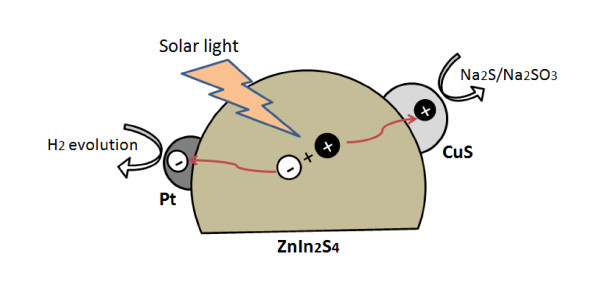
Schematic illustration of photo-generated charge-transfer process for photocatalytic hydrogen evolution over Pt-CuS/ZnIn2S4. From an aqueous solution containing Na2SO3/Na2S under simulated solar light.